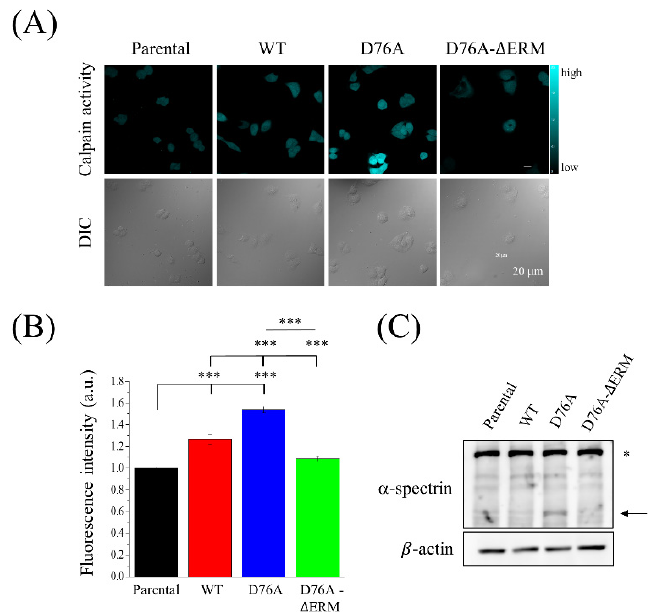
Figure 6. Calpain activity is influenced by the overexpression of different STIM1 variants. ( A ) Cells overexpressing different STIM1 variants were treated with t-BOC-LM-CMAC, which is an artificial fluorogenic calpain substrate, for 30 min. Confocal images showed the fluorescence intensity (upper panel) and the differential interference contrast (lower panel) of the cells. ( B ) Quantification of fluorescent intensity, which stood for calpain activity, from three independent experiments. Bars represent the mean ± SEM. *** p < 0.001 by one-way ANOVA. ( C ) Immunoblotting analysis using antibodies against the calpain substrate, α -spectrin. The stars and arrows indicate the intact and fragmented α -spectrin, respectively. β -actin served as the internal control.